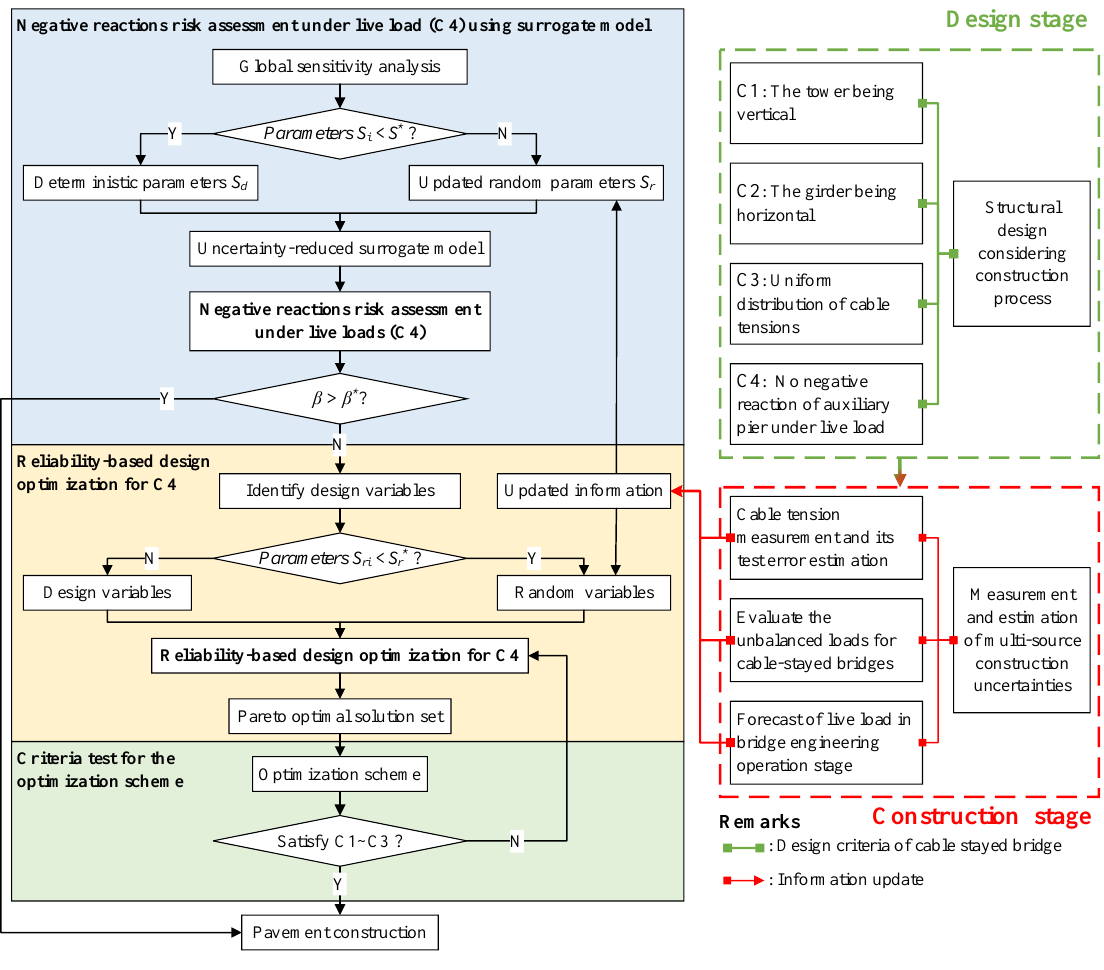
Figure 5. Framework of the TPOS.